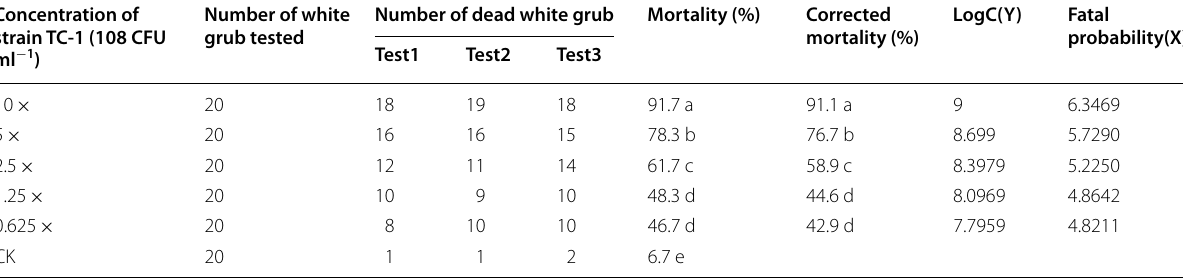
Data with different lowercases in each column indicate significant difference at P < 0.05 level